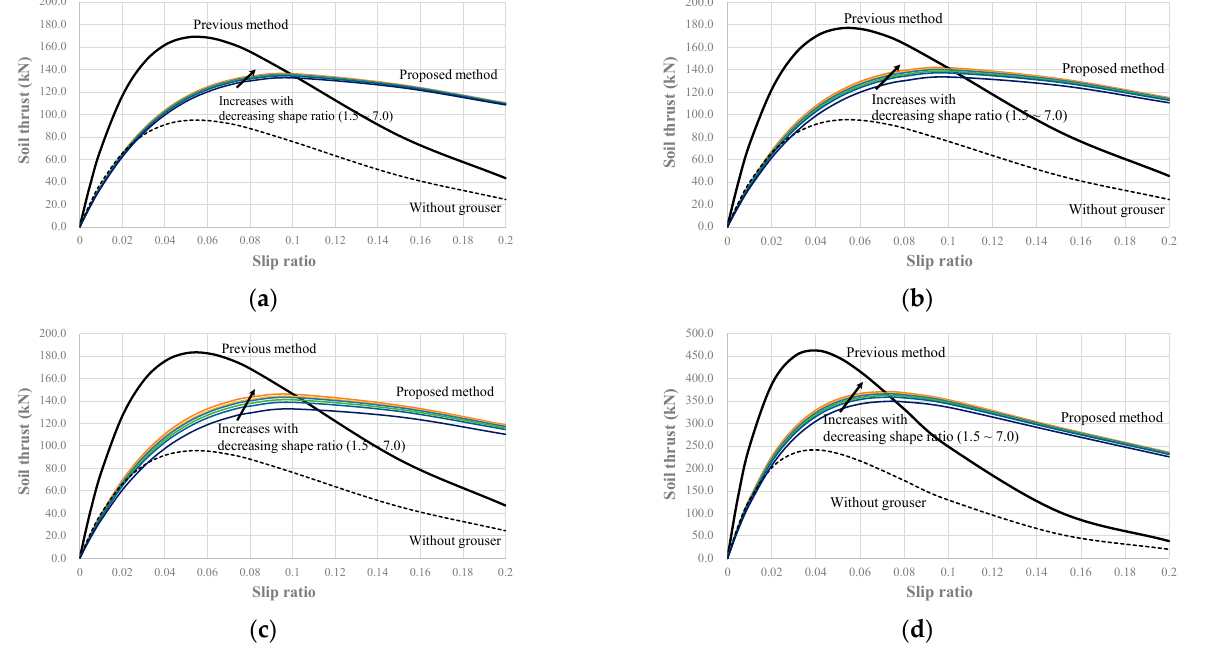
Figure 9. Soil thrust and slip displacement curves in soils exhibiting softening behavior ( c = 2.2 kPa, 𝜙 = 39.4° , K W = 6.1, K r = 0.659): EC145E with a grouser height of ( a ) 25 mm ( b ) 50 mm ( c ) 70 mm: ( d ) EC380E with 70 mm grouser height.